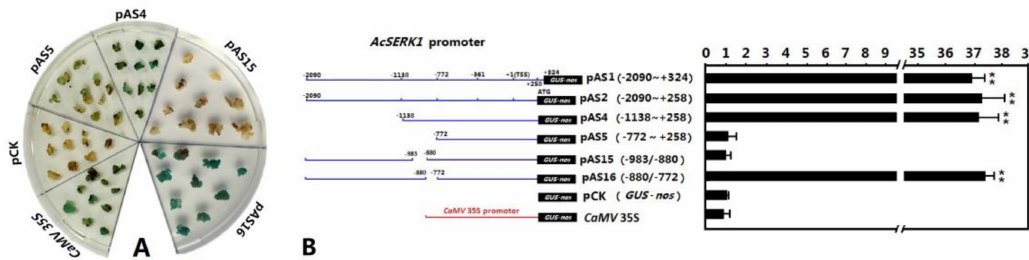
Figure 2. Deletion analysis of the embryonic cell-specific region in the 5 (cid:48) upstream regulatory region of AcSERK1 . ( A ) The results of GUS staining in the embryonic callus, ( B ) The quantitative measurements of promoter activity. The numbers in the vector map (left) indicate the deletion position. The vectors were co-infected with the internal standard vector CaMV 35S :: Fluc (pBI121-Fluc) into pineapple callus (embryonicandnon-embryonic). Thebarsrepresentrelativepromoteractivities(theratioofGUSactivity to Fluc activity) in the embryonic callus to those of the non-embryonic callus (i.e., embryo-specific promoter activity). The data represent the average of three biological replicates, and the error bars denote Standard Deviation (SD). ** highly significant ( p < 0.01), one-tailed t -test.